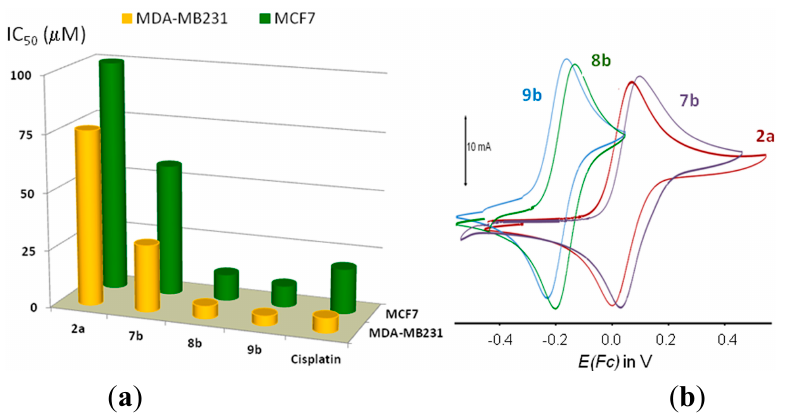
Figure 5. ( a ) Comparative plot of the cytotoxic activities ( IC 50 values (µM)) of complexes 2a , the platinacycles 7b – 9b and cisplatin in the MCF7 and MDA-MB231 breast cancer cell lines and ( b ) cyclic voltammograms (at a scan rate of 0.1 V × s −1 ) of the new Pt(II) complexes containing the aldimine 1 acting as a neutral N -donor (in 2a ) or as a monoanionic ((C Ph , N) − (in 7b ) or (C Fc , N) − (in 8b and 9b ))